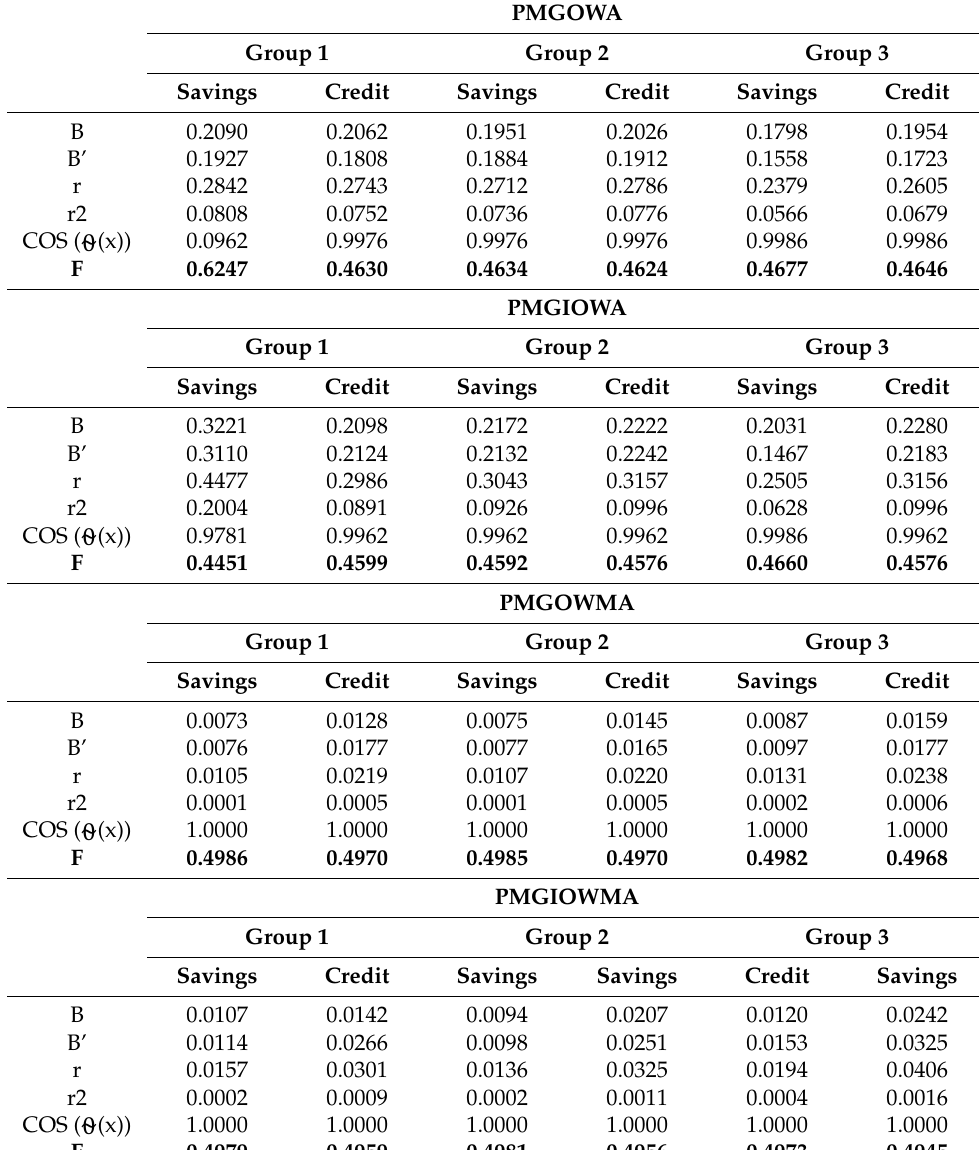
Table 8. Results of the PMGOWA, PMGIOWA, PMGOWMA and PMGIOWMA.